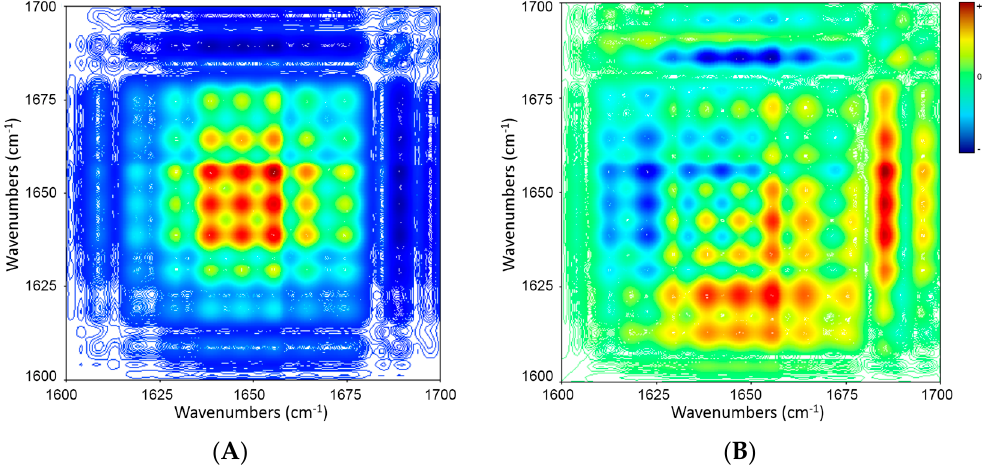
Figure 8. 2D IR synchronous ( A ) and asynchronous ( B ) maps of amide I bands of PSCs (5% w / v in D 2 O) during cooling (70 → 5 °C, in decrement of 5 °C). Red and blue color represent positive and negative correlation peaks, respectively.